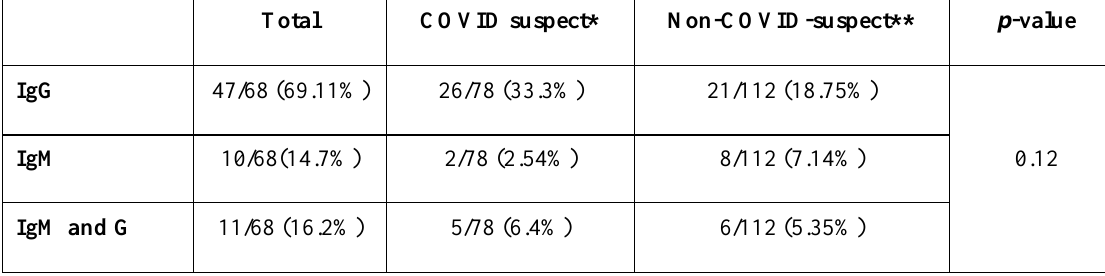
Table 2. Pattern of anti-SARS COV2 antibodies in relation of clinical suspicious of COVID-19.